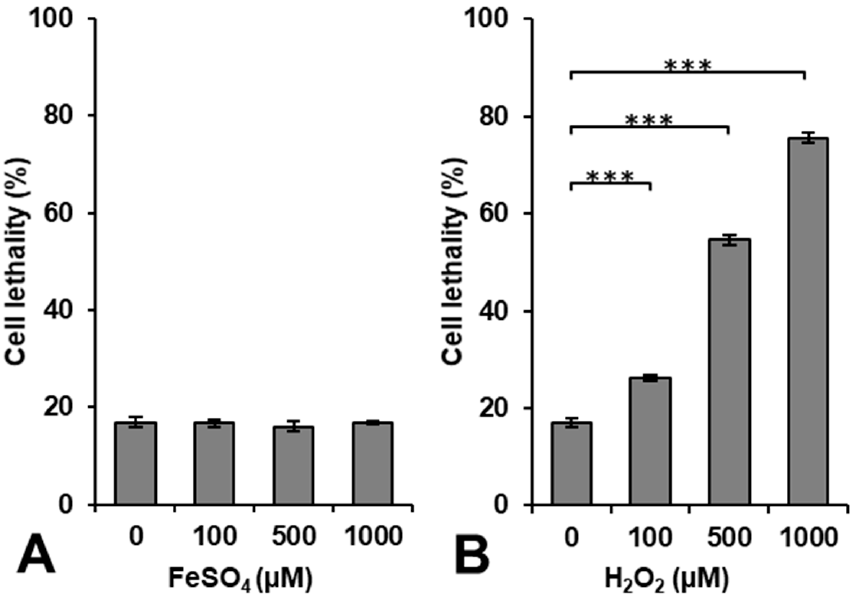
Figure 1. Estimation of cytotoxicity induced by the administration of H 2 O 2 or FeSO 4 alone. Cell lethality in rat thymocytes after a 5-min incubation with ( A ) FeSO 4 or ( B ) H 2 O 2 . Columns and error bars indicate the average and SD of three experiments. *** indicates a significant difference of p < 0.001.